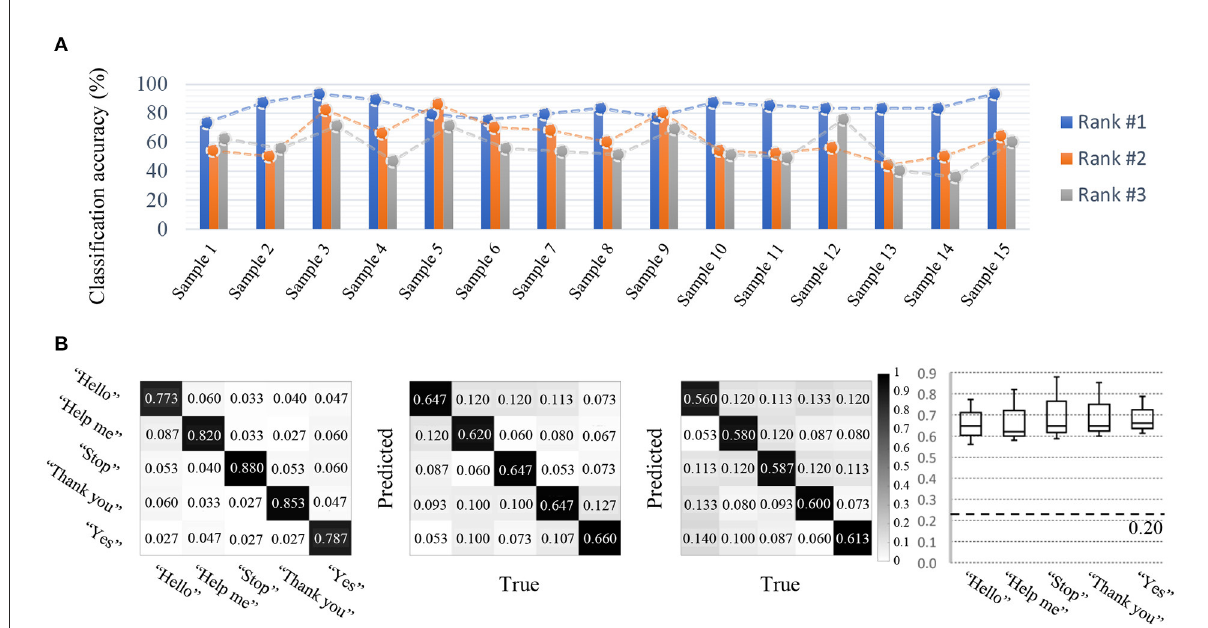
FIGURE8 Competition outcomes. (A) Imagined speech BCI results (accuracy). (B) For imagined speech BCI, the true positive rate of every class demonstrated a true positive rate above the baseline, however, high variation was found among the different classes. In addition, the results showed different tendencies according to each participant’s